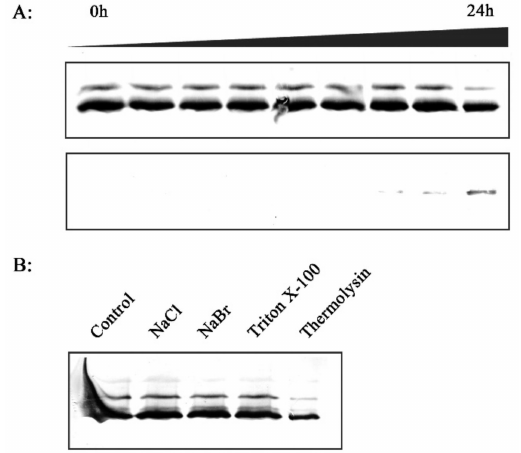
Figure 3. Stability of the association of RCA with the thylakoid membrane. ( A ) Thylakoids were isolated from leaves of O. meyeriana inoculated with Xoo and then incubated in HEPES-KOH bu ff er solution to release RCA from the thylakoid membrane for 0, 1 / 6, 1 / 2, 1, 2, 3, 6, 12, 24 hours. ( B ) Isolated thylakoid membrane washed with 2 M NaCl or 2 M NaBr, or treated for 30 min. with 1% Triton